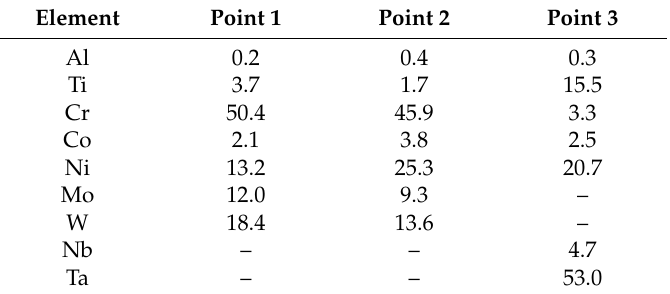
Figure 3. SEM image (BSE signal) of the interphase between IL aluminide coating and IN738 substrate. Numbers indicate the spots on which EDS analysis was performed. Scale bar 25 μ m. Table 1. EDS spot analysis over the points depicted in Figure 2.